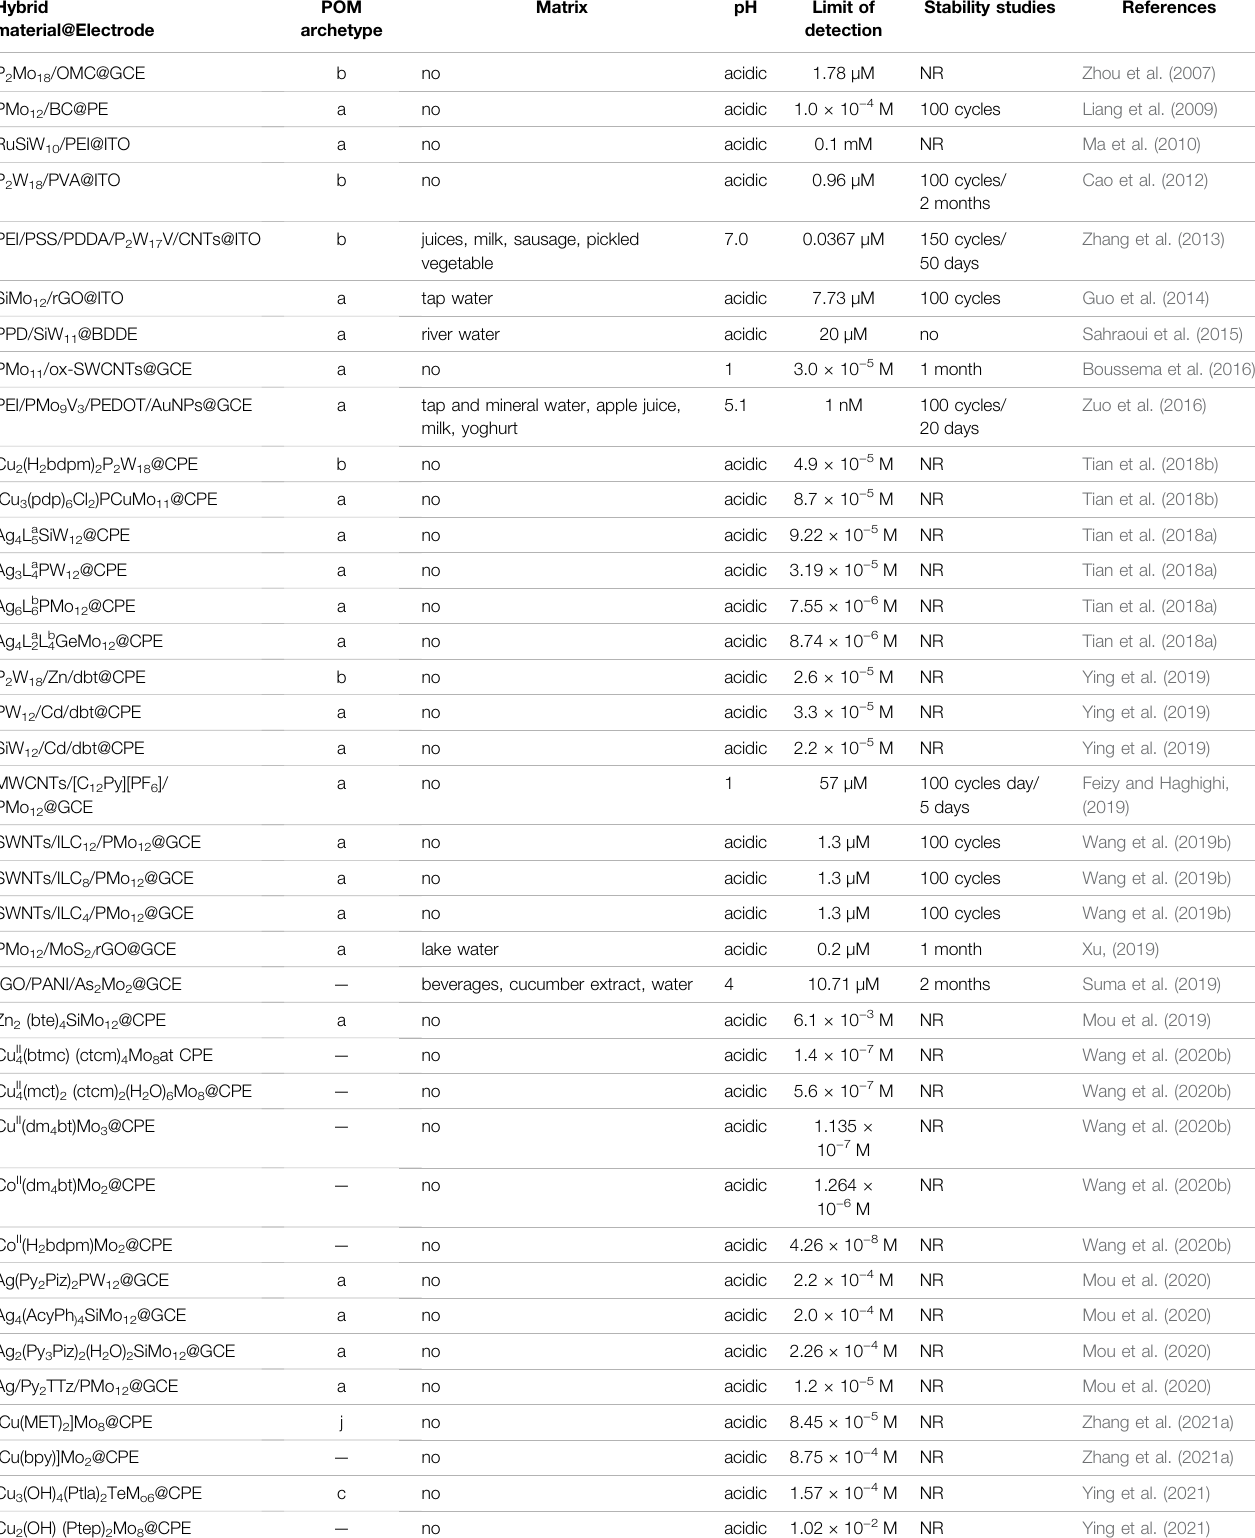
TABLE 2 | POM-based electrochemical sensors for NO 2 − detection. Hybrid